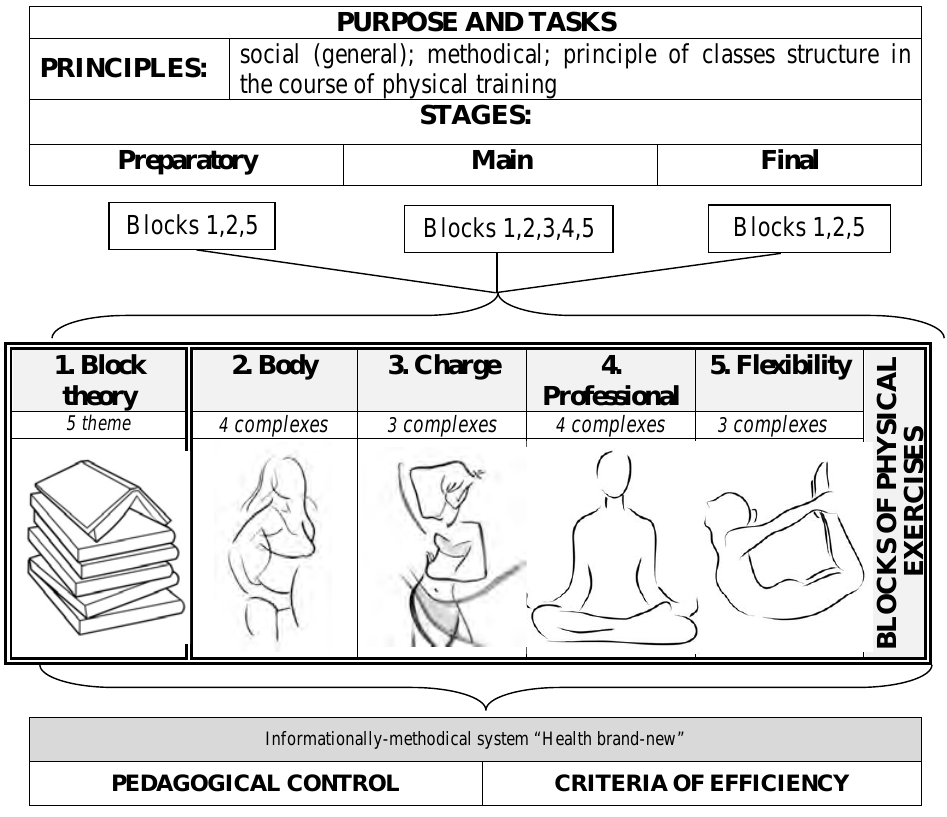
Fig. 1. The diagram of the technology aimed at the development of PSPQ of future specialists of sewing industry with use of information